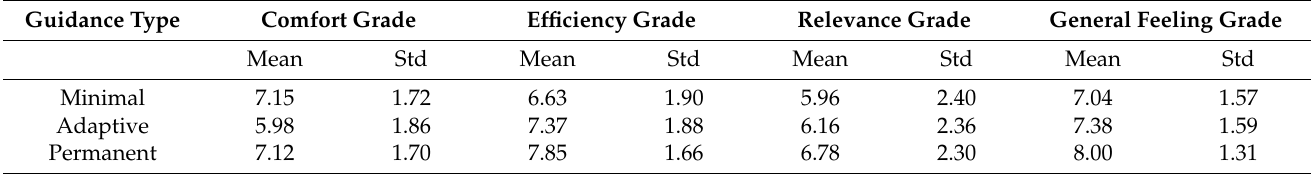
Table 6. Participants grades for the four criteria described in Section 4.2.2. Task and